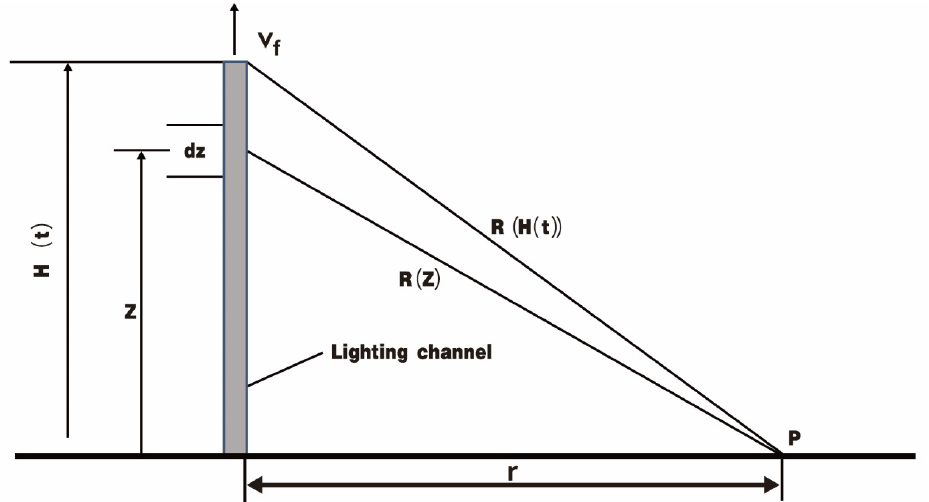
Figure 1. Schematic diagram for the derivation of E -field and B -field at point P on the ground surface. It is presumed that the ground plane is an ideal conductor, and r is the horizontal distance.